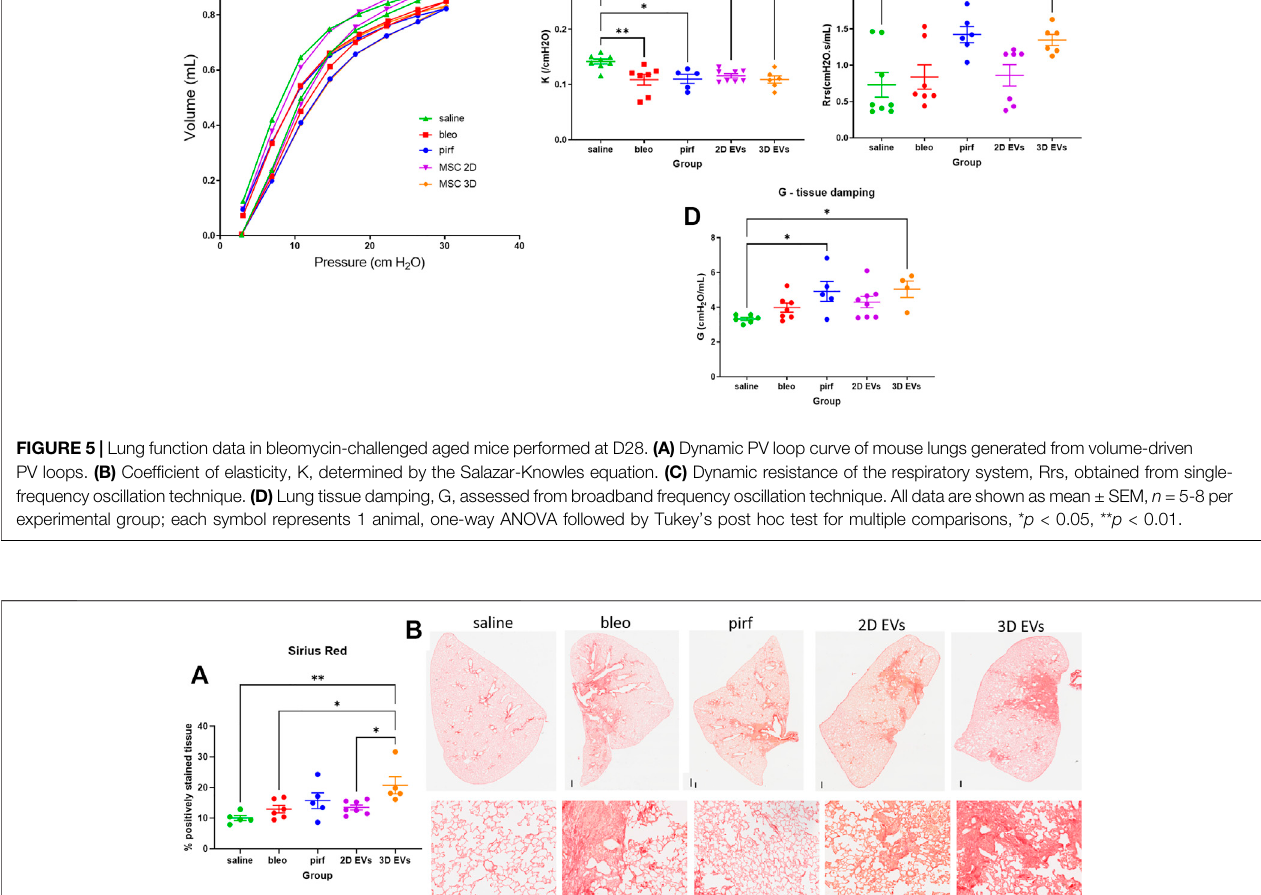
Frontiers in Cell and Developmental Biology |